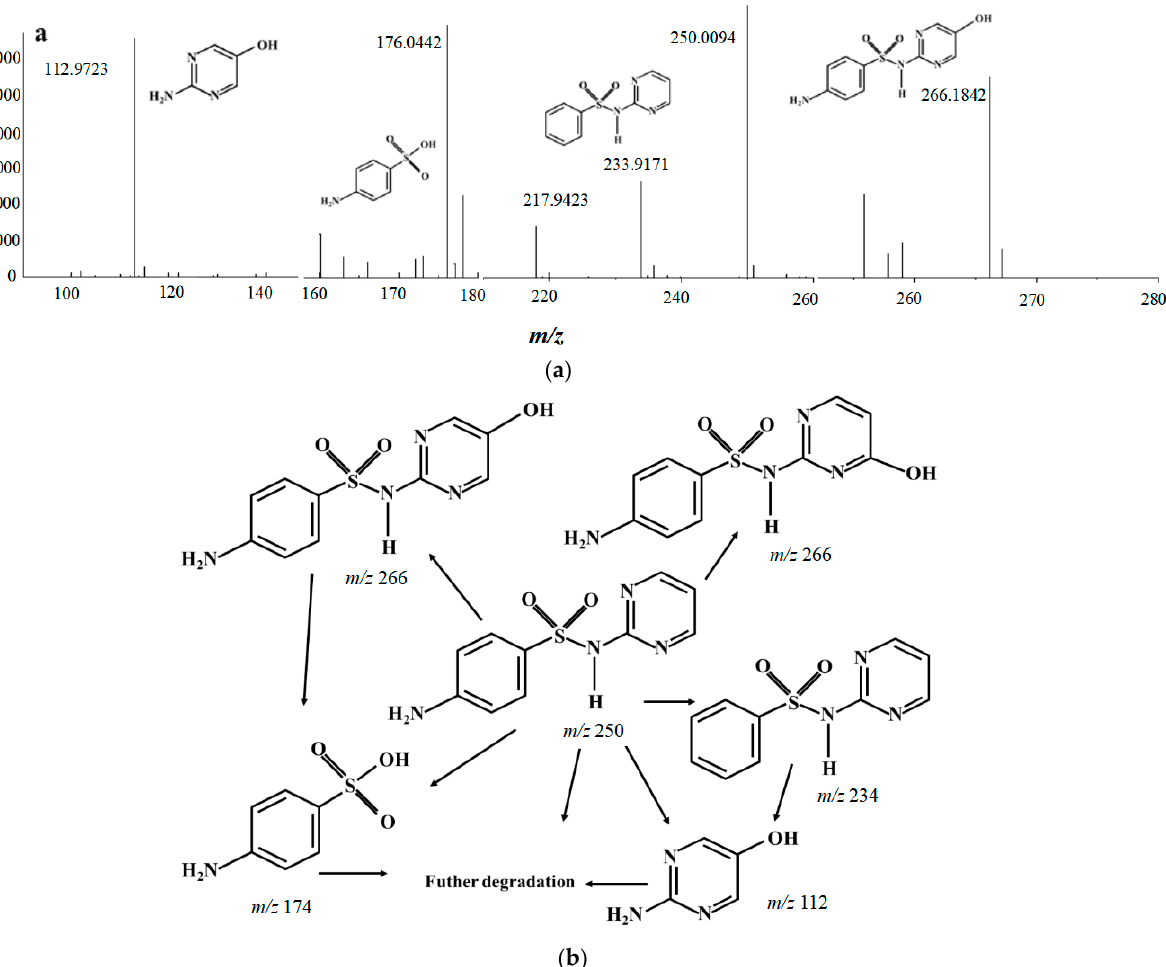
Figure 5. The main transformation pathways of SND. ( a ) MS spectra of SND degradation byproduct; ( b ) Hypothesis of degradation pathways of SND.